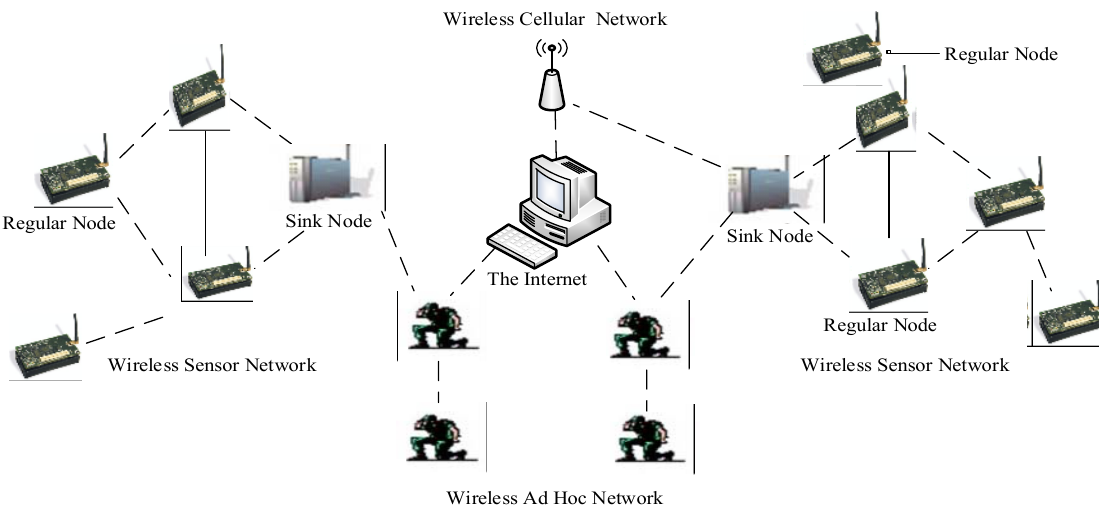
Figure 1. General architecture of wireless sensor networks (Source: Haque et al. 2015)